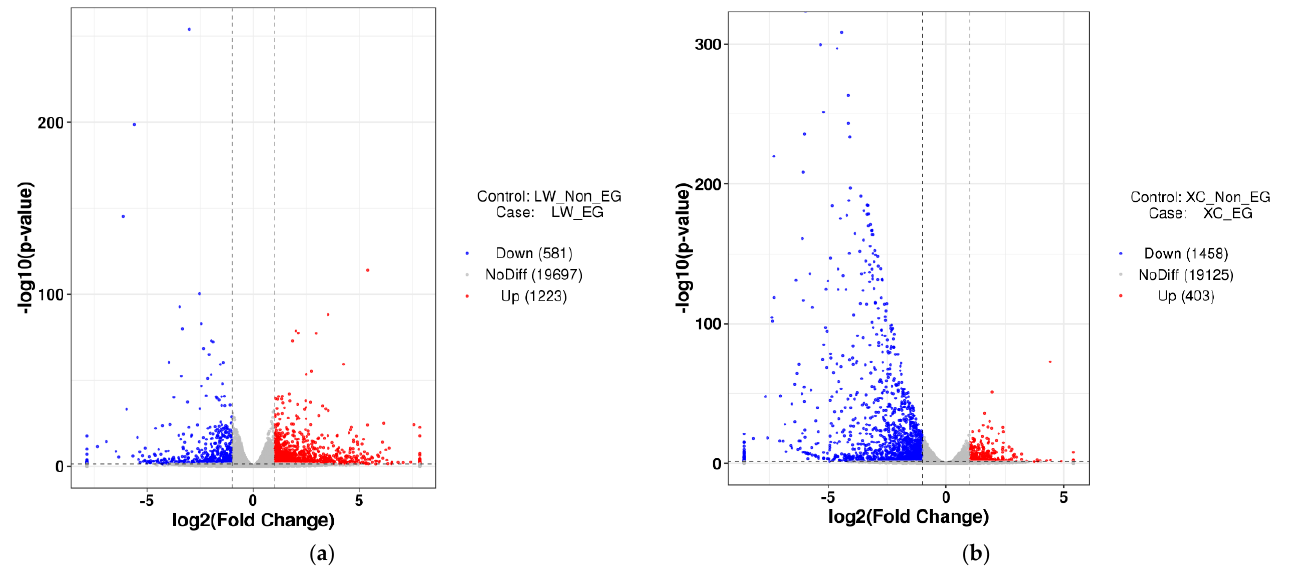
Figure 4. Changes in gene expression in fruits of two late-ripening sweet oranges, Lane Late Navel (LW) ( a ) and Rohde Red Valencia (XC) ( b ) after foliar spray of easily extractable glomalin-related soil protein (EE-GRSP). Abbreviation: LW_EG, the LW variety sprayed with EE-GRSP; LW_Non_EG, the LW variety not sprayed with EE-GRSP; XC_EG, the XC variety sprayed with EE-GRSP; XC_Non_EG, the XC variety not sprayed with EE-GRSP.